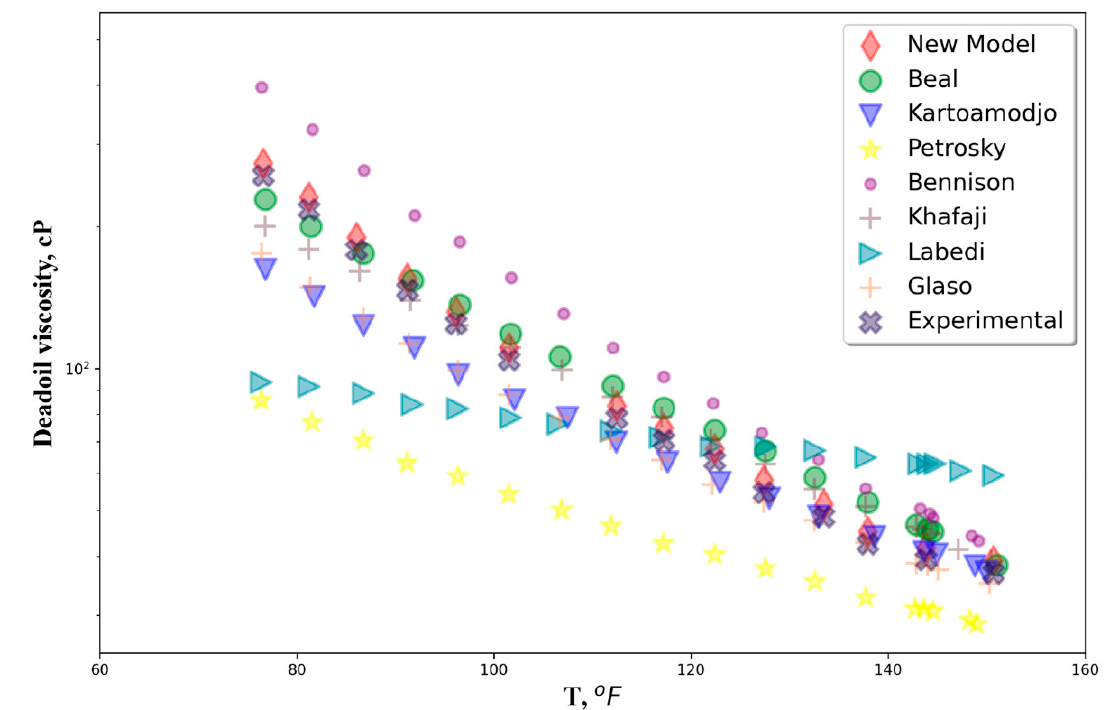
Figure 4. Dead oil viscosity from most leading correlations at various temperatures.